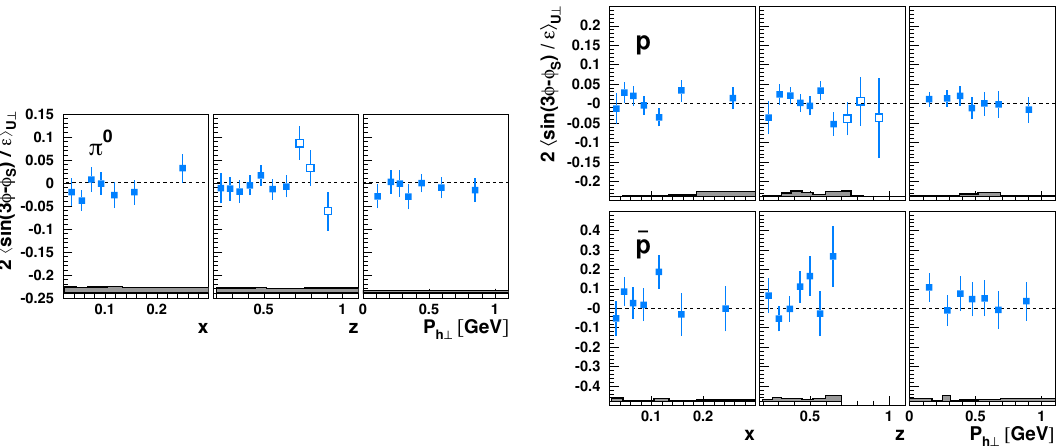
Figure 20 . Pretzelosity SFA for π 0 (left), protons, and antiprotons (right) presented either in bins of x , z , or P h ⊥ . Data at large values of z , marked by open points in the z projection, are not included in the other projections (no such high- z points are available for antiprotons due to a lack of precision). Systematic uncertainties are given as bands, not including the additional scale uncertainty of 7.3% due to the precision of the target-polarization